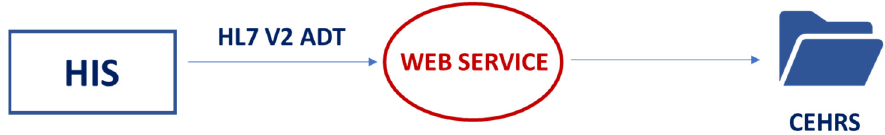
Figure 4. CEHRS Interfaces with other components of the HIS.